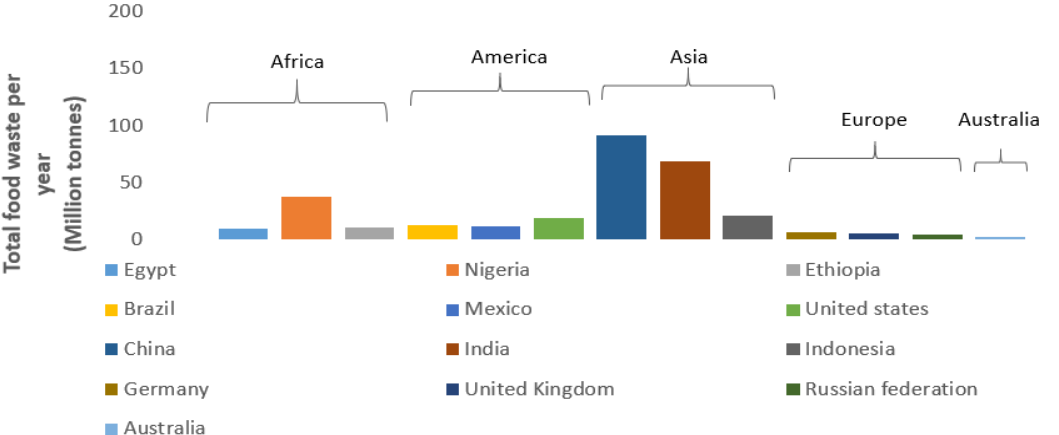
Figure 2. Estimates of food waste from households across the world. Source of data: United Nations Environment Programme’s 2021 Food Waste Index [1].